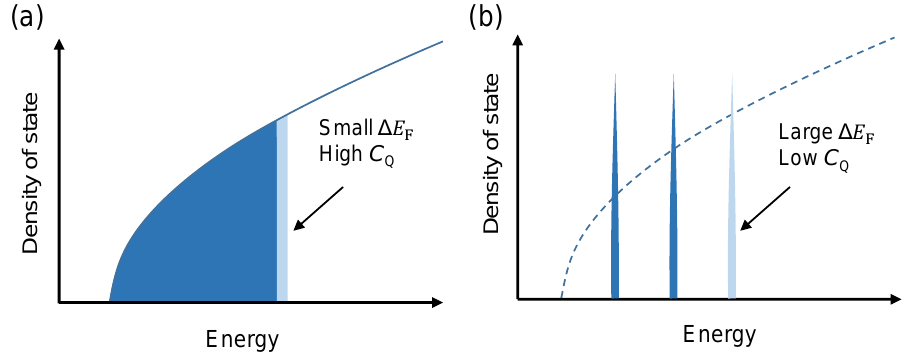
Figure 6. Relationship between quantum capacitance and density of states. ( a ) For bulk materials, the variation in electron concentration has a limited impact on the position of the Fermi level, and the quantum capacitance is large; ( b ) For quantum dots, electron gain and loss can cause a significant change in the Fermi level position, and the quantum capacitance is small.